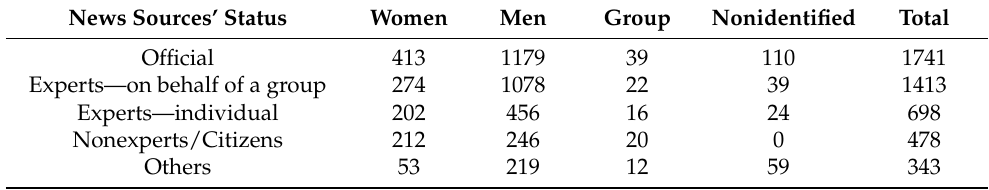
Table 1. Human news sources quoted in COVID-19 news pieces (absolute numbers).